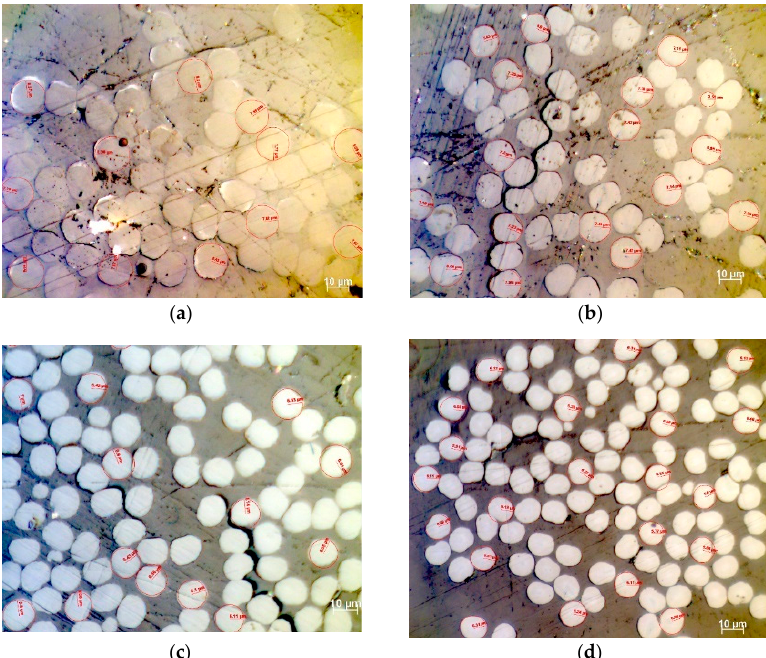
Figure 14. Optical Microscopy of stabilized PAN fibers at temperatures of ( a ) 160 °C, ( b ) 210 °C, ( c ) 230 °C, and ( d ) 260 °C. Table 5. Synopsis of alternation of PAN cross-sectional area investigation results through optical microscopy (OM).